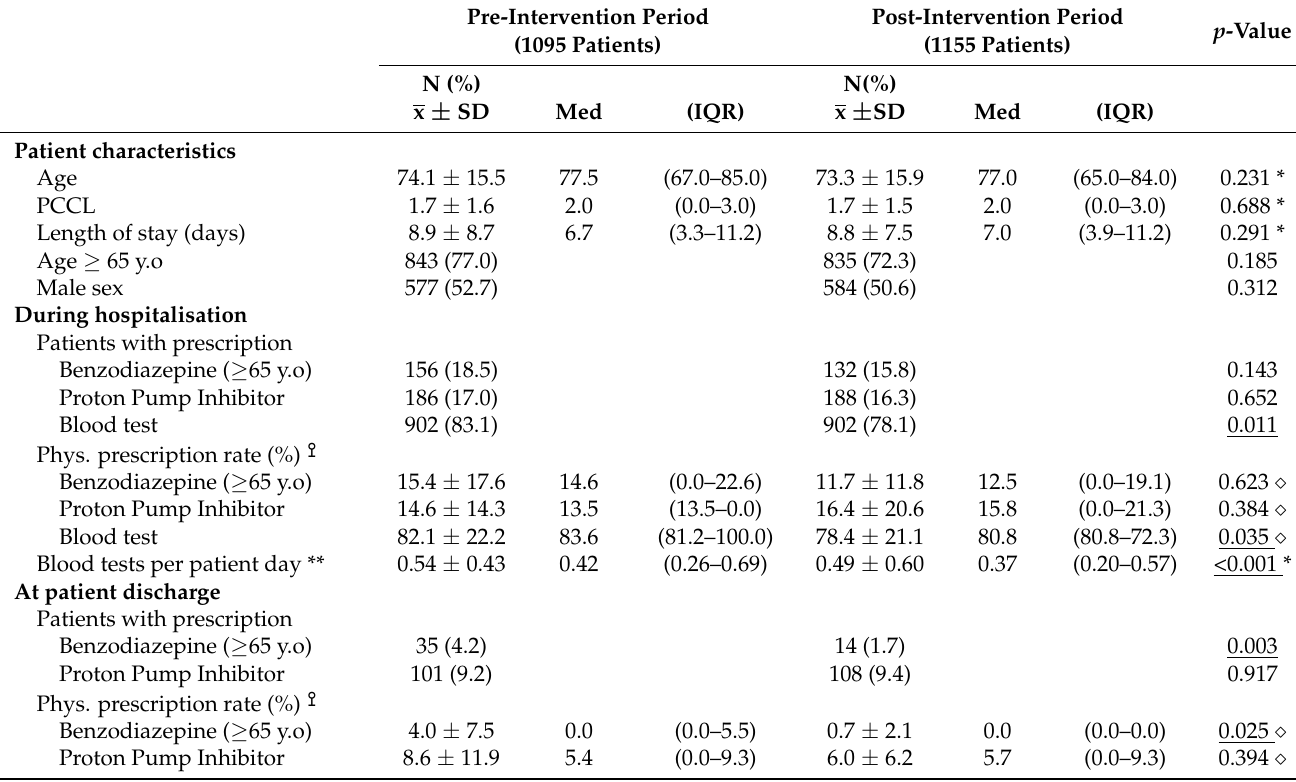
Table 1. Prescription differences between the pre- and post-intervention periods.